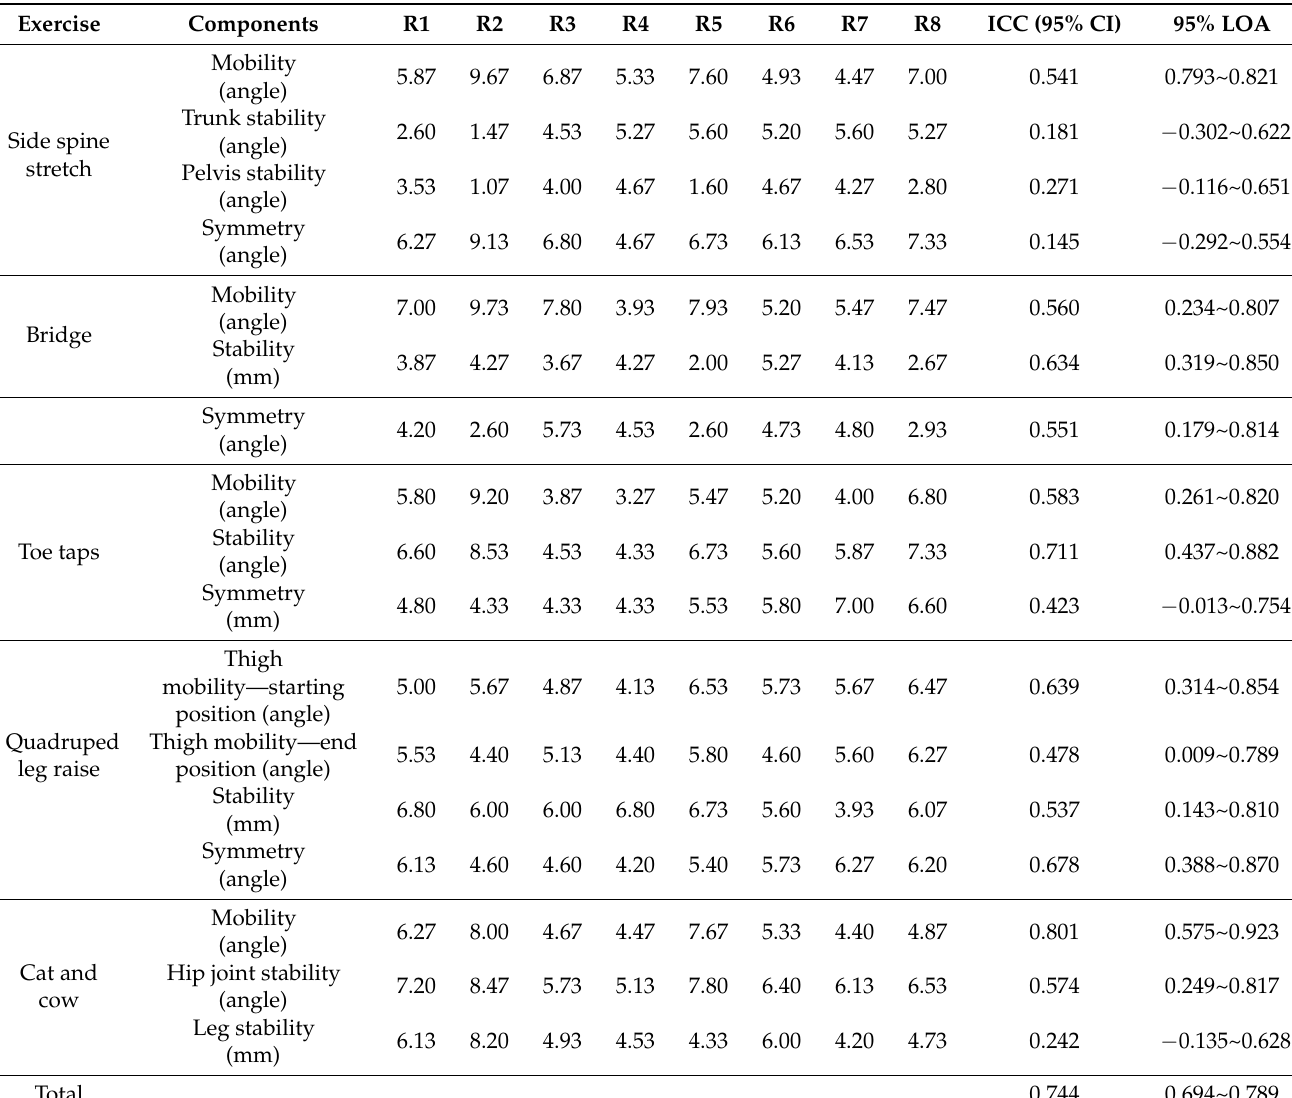
Table 3. Inter-rater reliability of the raters in tele-assessment using video conference